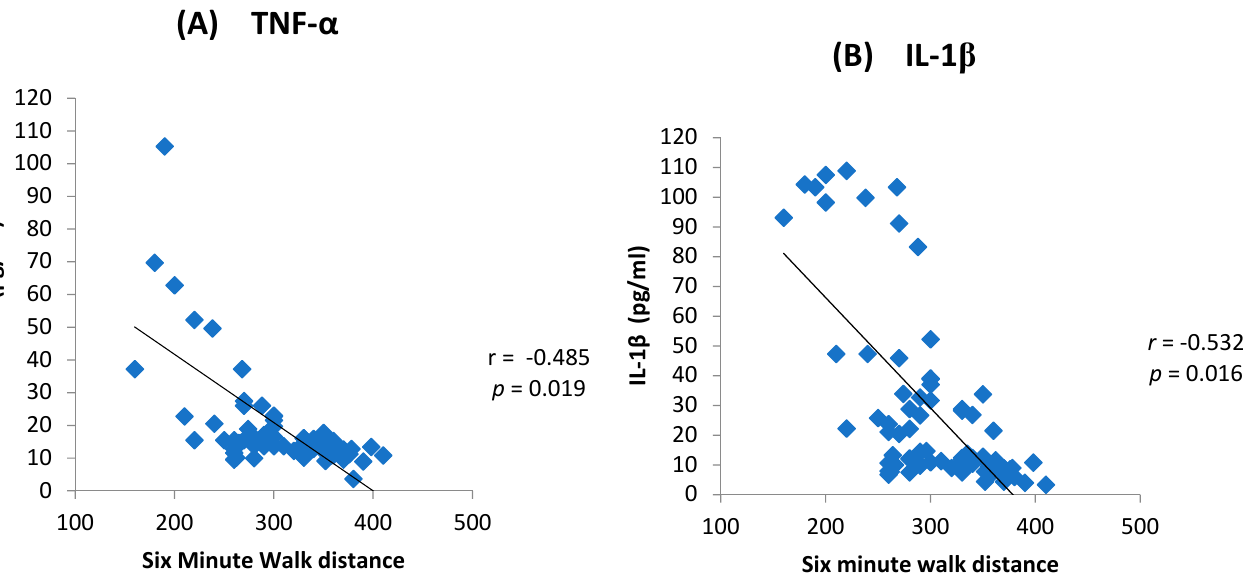
Figure 6. Correlation between Six min walk test and levels of ( A ) TNF- α (pg/mL) and ( B ) IL-1 β (pg/mL) among the cases.